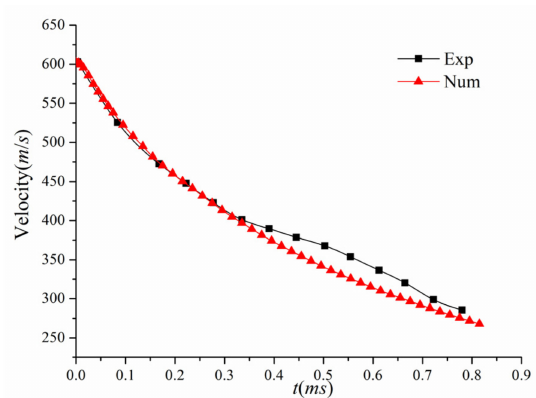
Figure 3. Numerical results and experimental data of underwater velocity